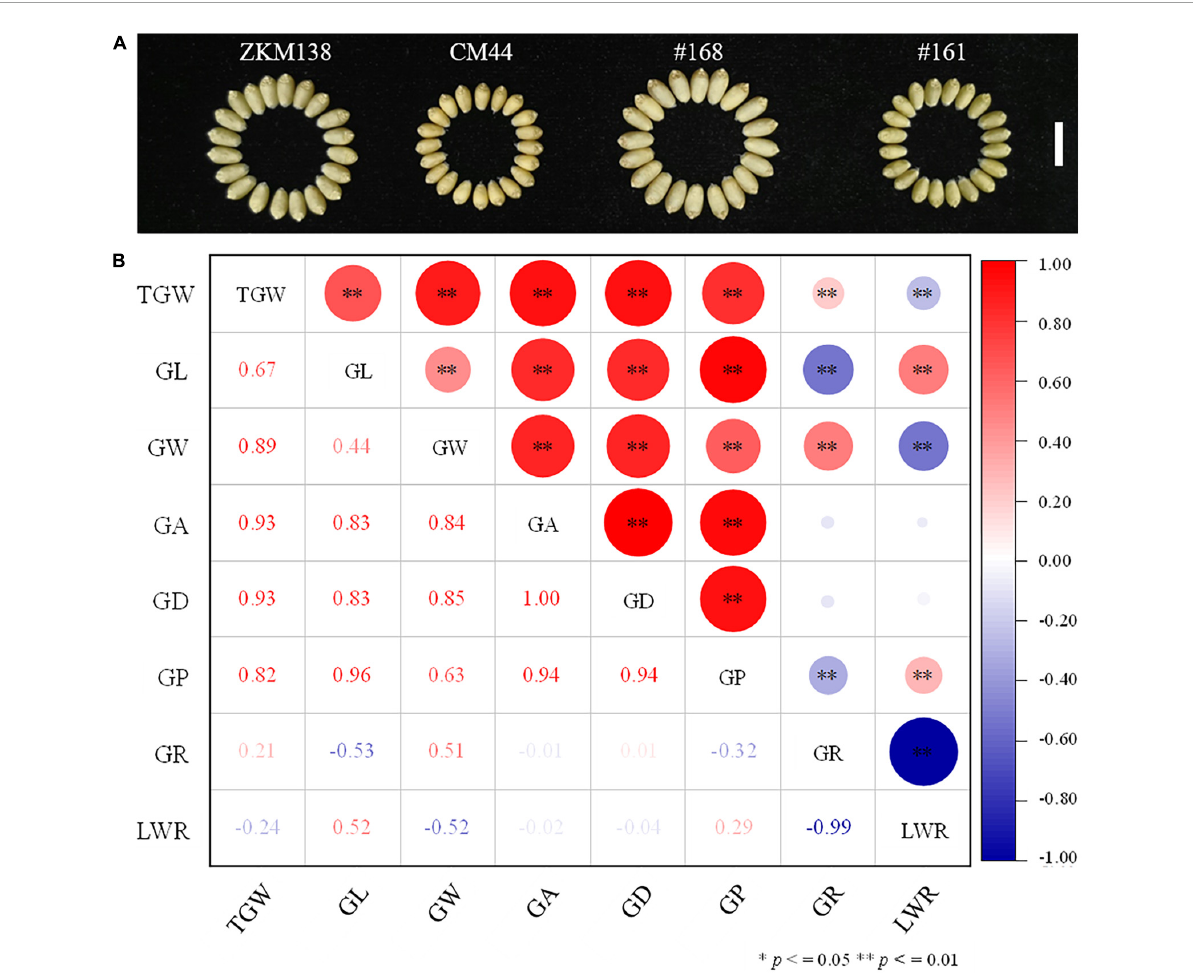
FIGURE1 Performance of the measured grain related traits in the BC-RILs population. (A) Grain phenotype of the parents ZKM138 and CM44, and two representative lines of the BC-RILs population. The white line represents a scale = 1 cm. (B) Correlation analysis between TGW and GRTs in the BC population based on the BLUE dataset. ∗ and ∗∗ indicate significance at P ≤ 0.05 and P ≤ 0.01,